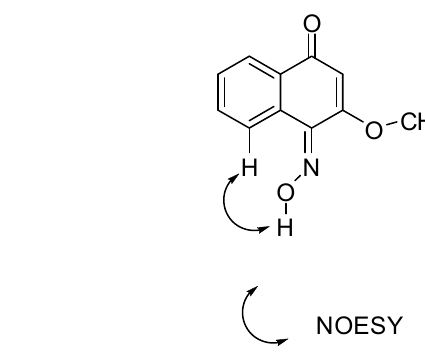
Figure 3. Structure of compound Z-9-2